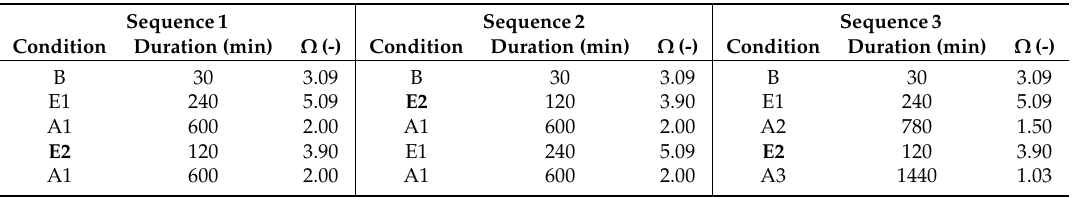
Table 1. Sequences of wave conditions, their duration and dimensionless sediment settling velocity Ω . Sequence1